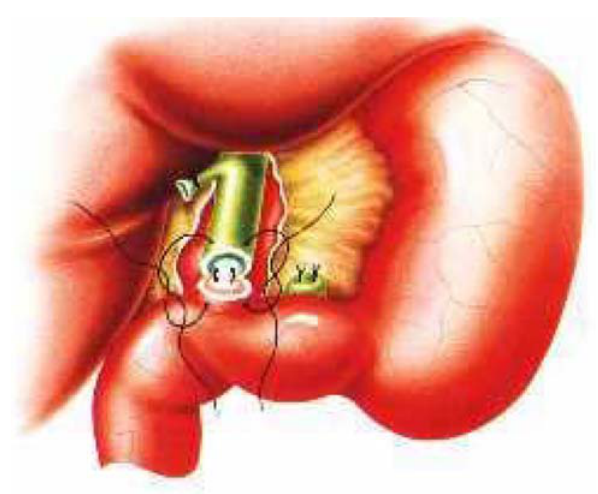
FIGURA 5 – Desenho mostra a sutura da parede anterior do colédoco à parede anterior do duodeno.